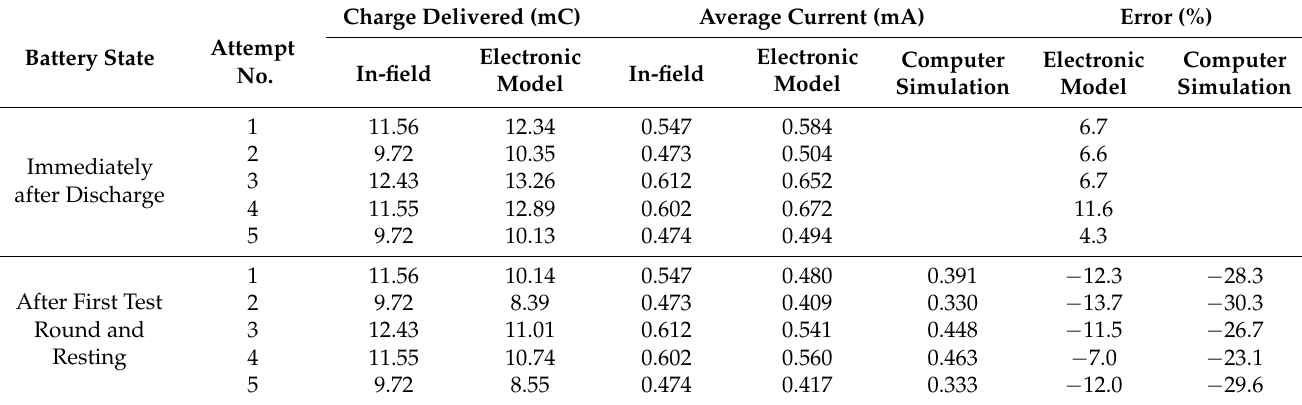
Table 4. Electric charge from the transducer as measured in real terrain and yielded by the electronic model.